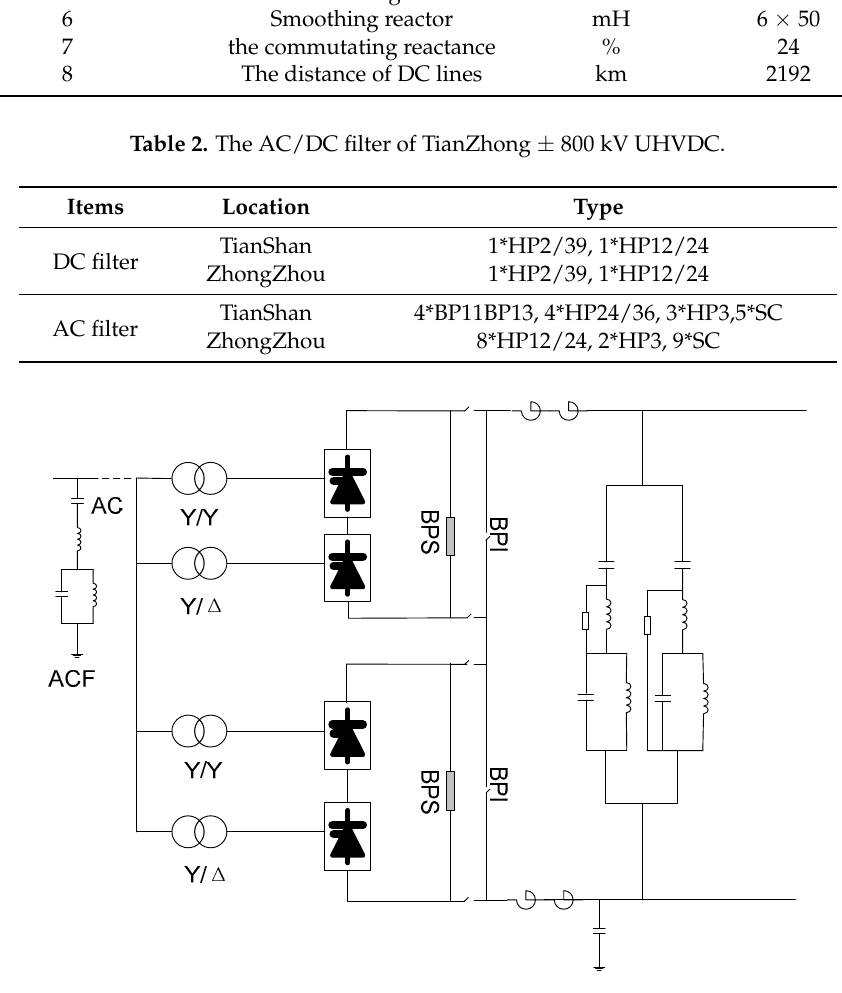
Figure 11. A simplified diagram of the TianZhong ± 800 kV UHVDC transmission project.